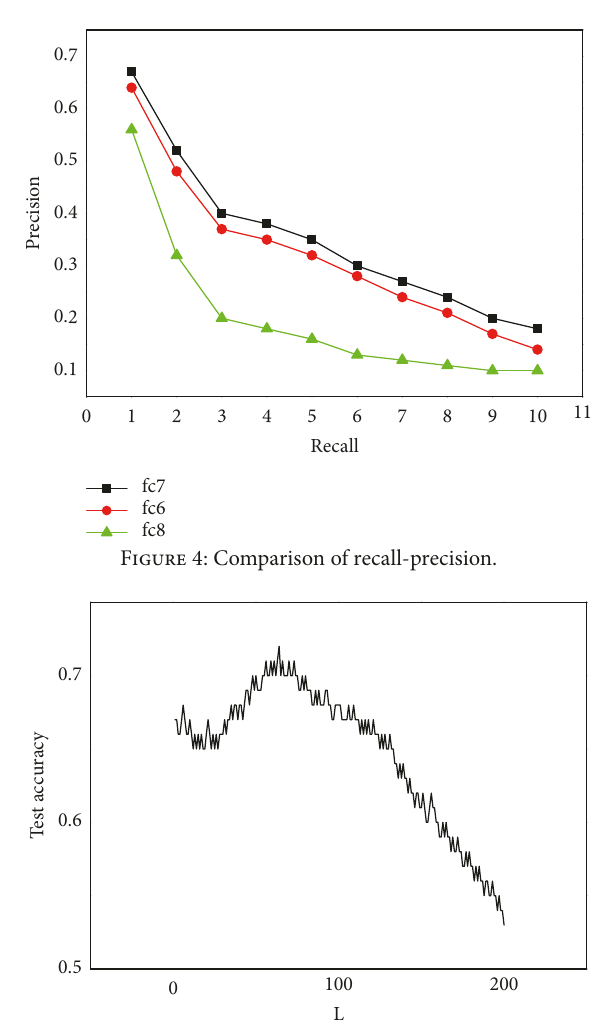
Figure 5: Relationship between L and test